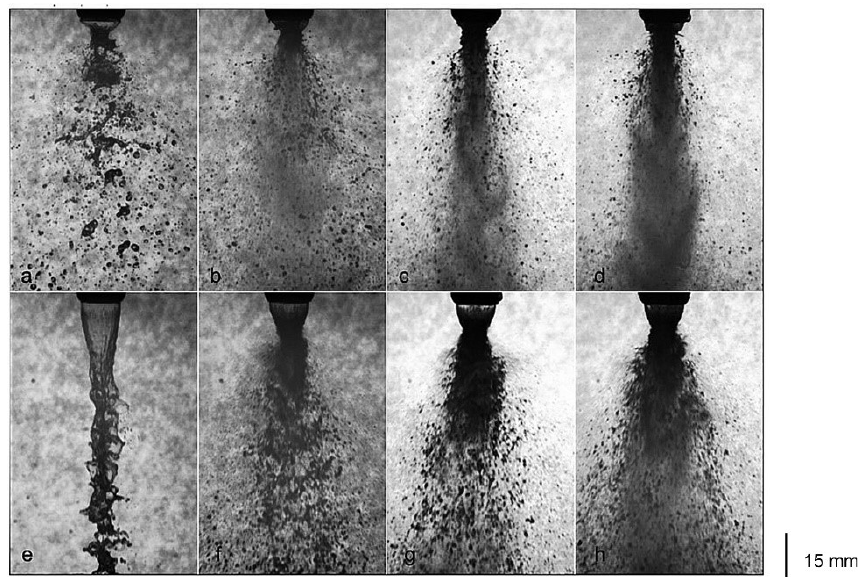
Figure 6. For the converging–diverging (CD) atomizer at 100 kg/h ( top row ) and 350 kg/h water flow rates for 280 µ m sheet thickness with airflow rates of ( a , e ) 5 kg/h, ( b , f ) 15 kg/h, ( c , g ) 25 kg/h, and ( d , h ) 35 Kg/h, respectively.